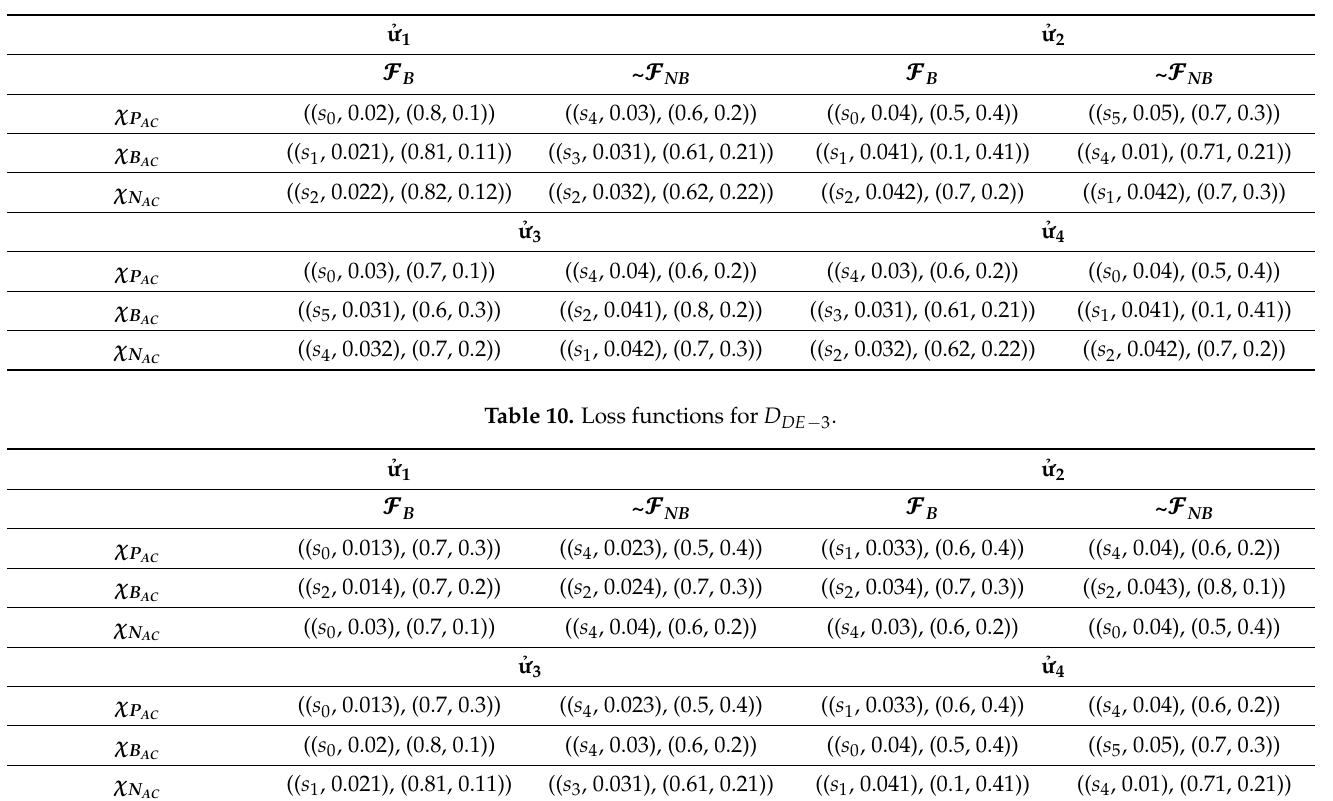
Table 9. Loss functions for D DE − 2 .